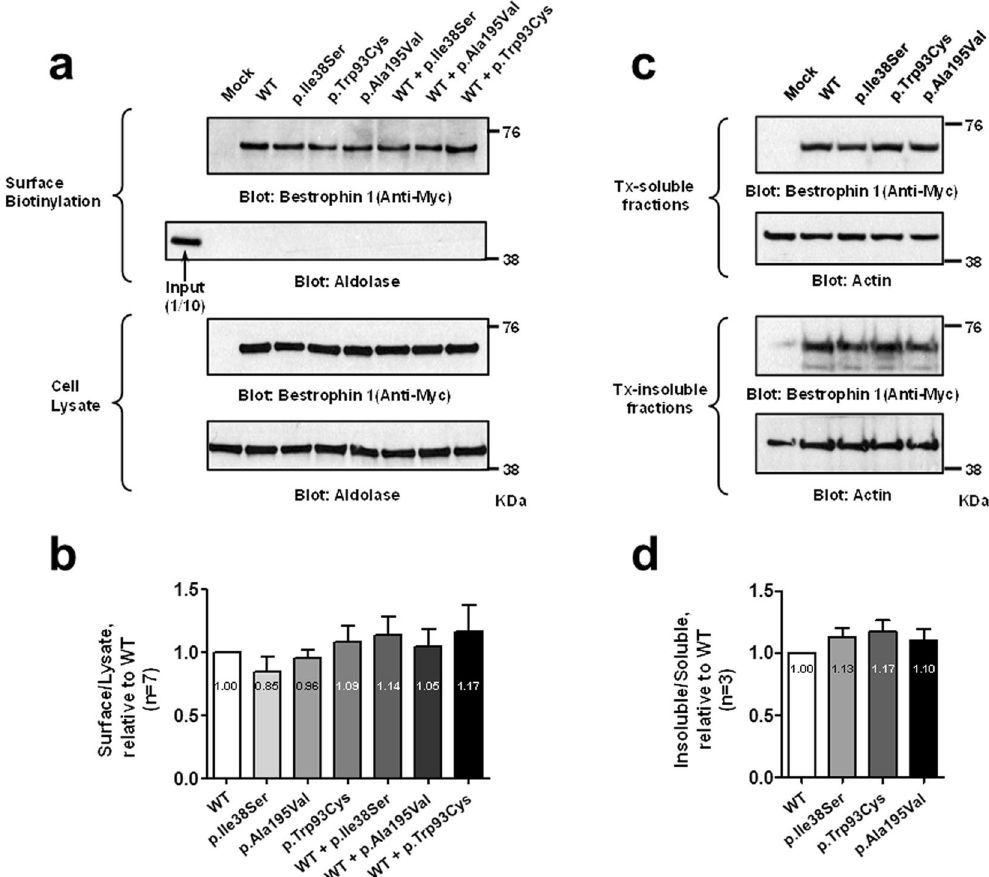
Figure 3. BEST1 p.Ile38Ser mutation does not interfere with membrane expression. HEK293T cells were transfected with plasmids expressing wild type and mutant hBEST1. (a) Surface biotinylation assays of hBEST1 were performed. (b ) Quantitation of multiple experiments shows that the membrane expression was not different among groups by ANOVA (P = 0.589). Fold changes relative to WT are provided. (c) Detergent solubility assay of wild type and mutant hBEST1. (d) Quantification of multiple experiments shows that the detergent solubility was not different among the groups by ANOVA (P = 0.300). Fold changes relative to WT are provided. Western blots were cropped to show specific bands only. For uncropped blots see Supplementary Fig.